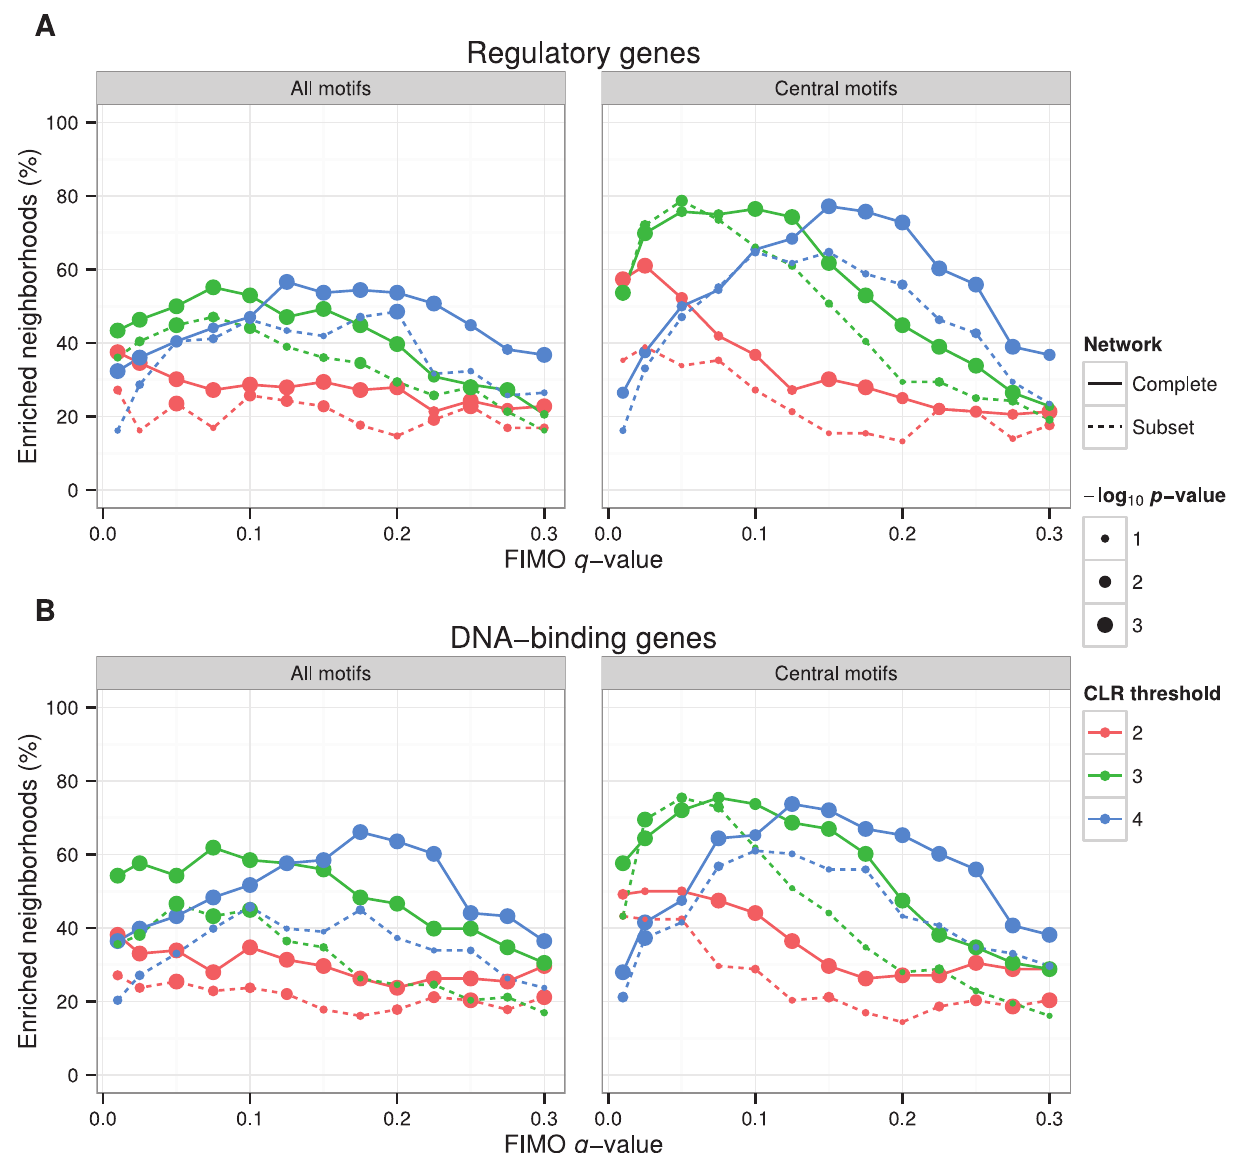
Figure 4. Gene co-expression neighborhoods with significant motif enrichment. The figure plots the fraction of neighborhoods for regulatory genes (A) and DNA-binding genes (B) with at least one significantly enriched motif ( q , 0.05) against the q -value threshold for mapping motifs to the genome. The fractions are calculated from the total number of genes in the respective groups that have gene expression data (118 DNA-binding genes and 136 regulatory genes). Plots are shown for all motifs and the subset of central motifs as well as for the complete and subset co-expression networks with different CLR thresholds. P -values are given for each combination of parameters and indicate the probability of observing the reported fraction of enriched neighborhoods in randomized